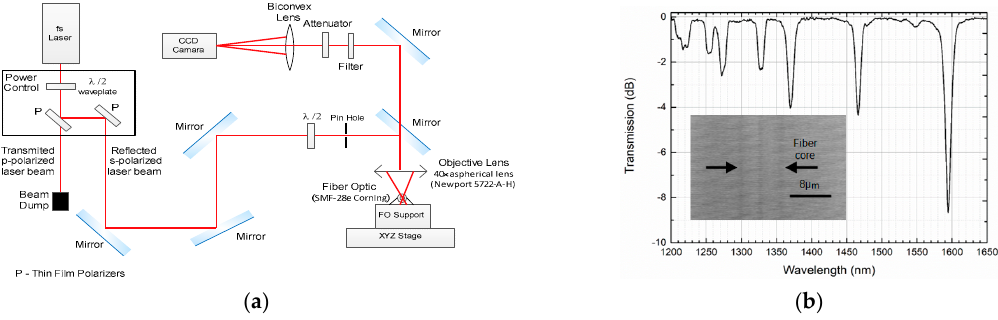
Figure 1. Femtosecond Laser System for LPFGs Fabrication: ( a ) Schematic diagram; ( b ) Transmission spectra of femto-inscribed LPFG (inset: Grating structure inside of fiber optic